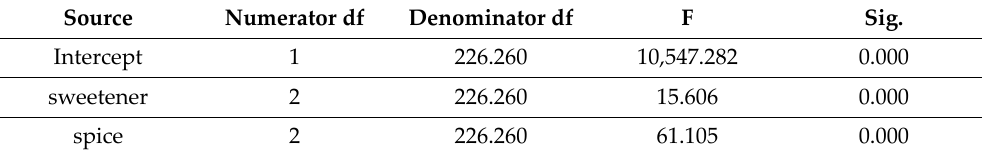
Table A3. Type III Tests of Fixed Effects for Antioxidant Capacity (FRAP, from